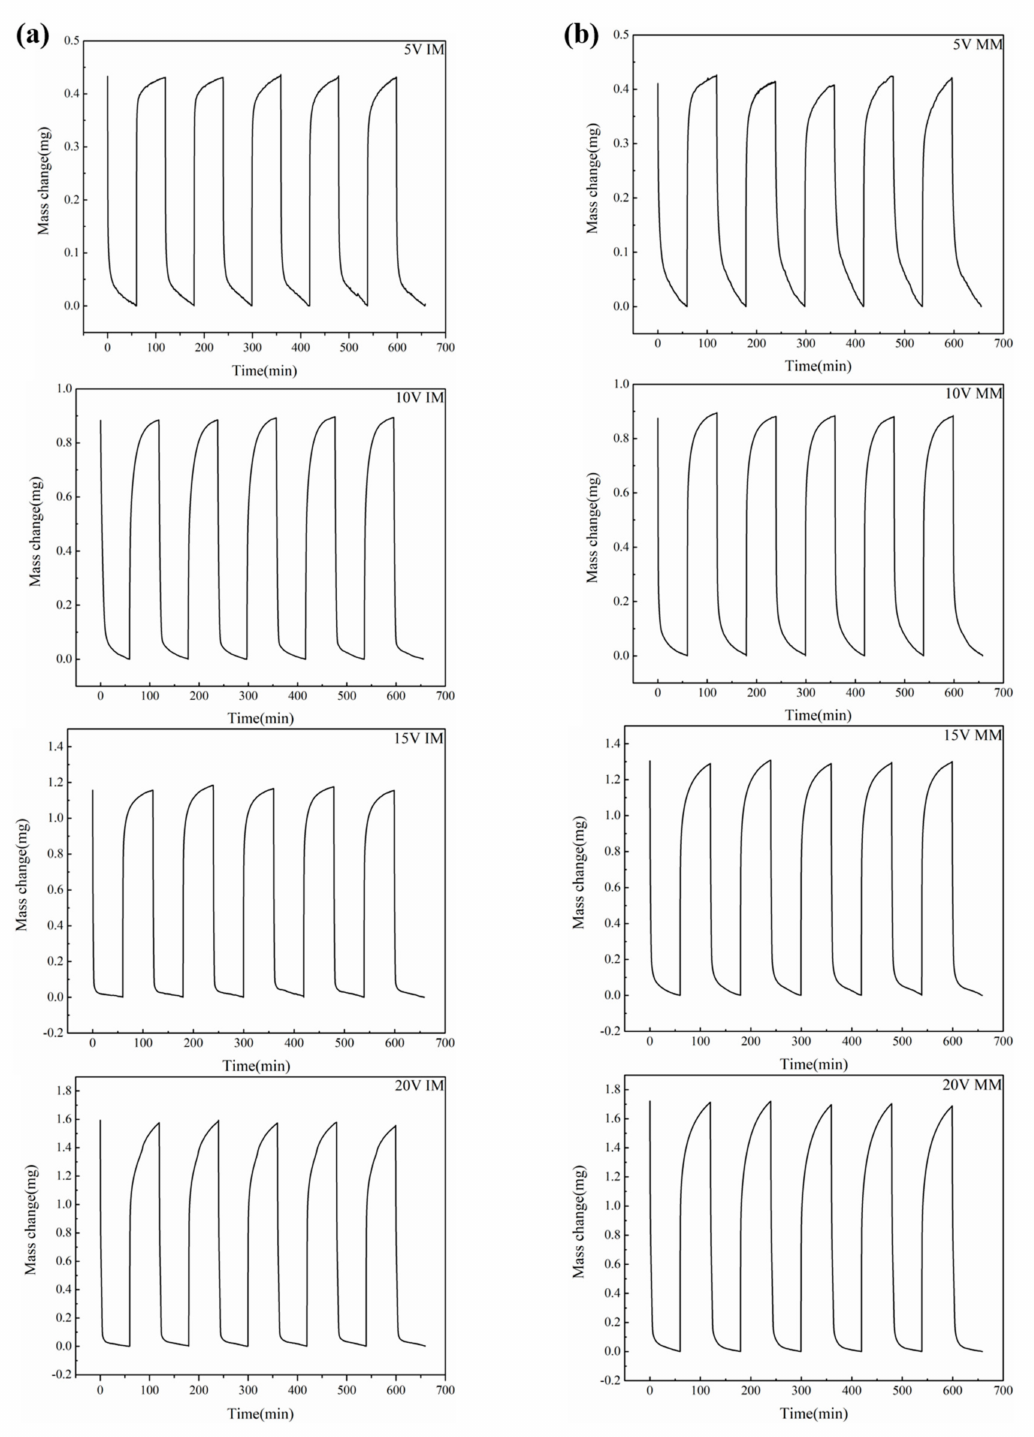
Figure 4. Isothermal redox cycles profiles for V-based oxygen carriers with different V loadings and preparation methods: ( a ) Impregnation method, ( b ) Mechanical